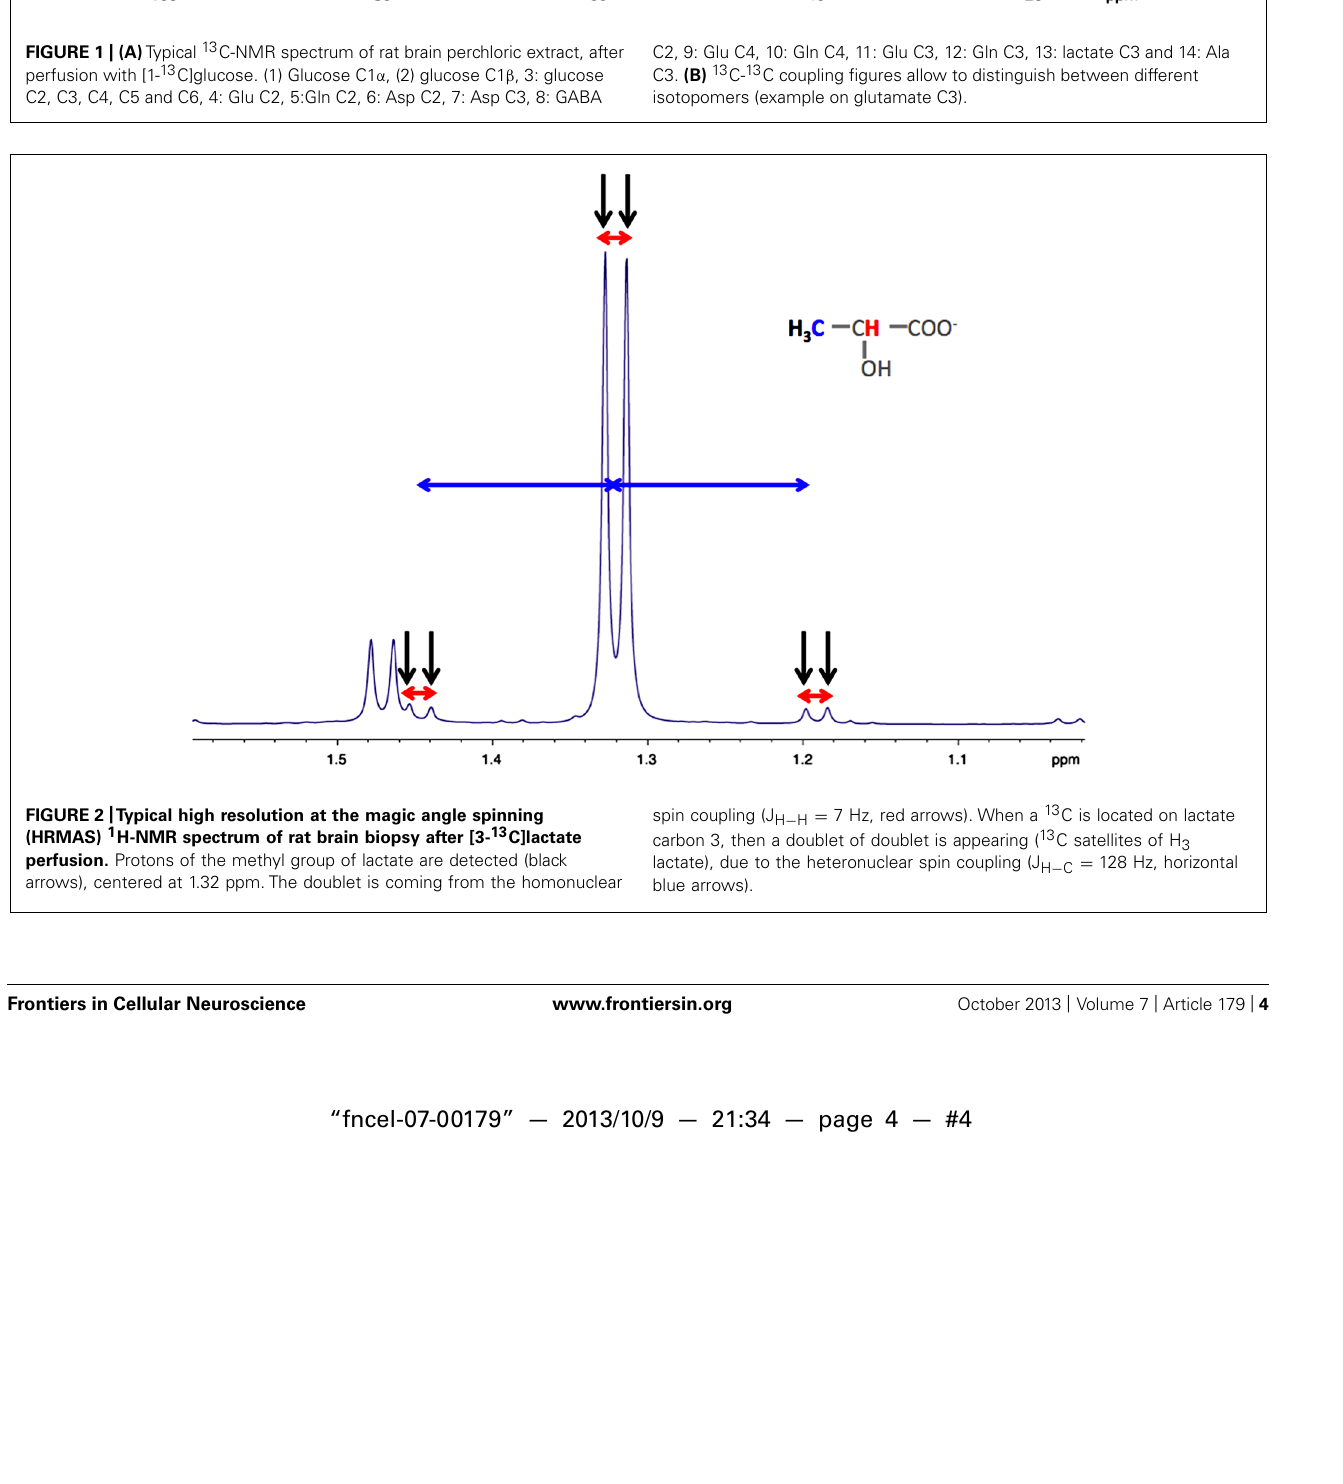
C2, 9: Glu C4, 10: Gln C4, 11: Glu C3, 12: Gln C3, 13: lactate C3 and 14: Ala C3. (B) 13 C- 13 C coupling figures allow to distinguish between different isotopomers (example on glutamate C3).